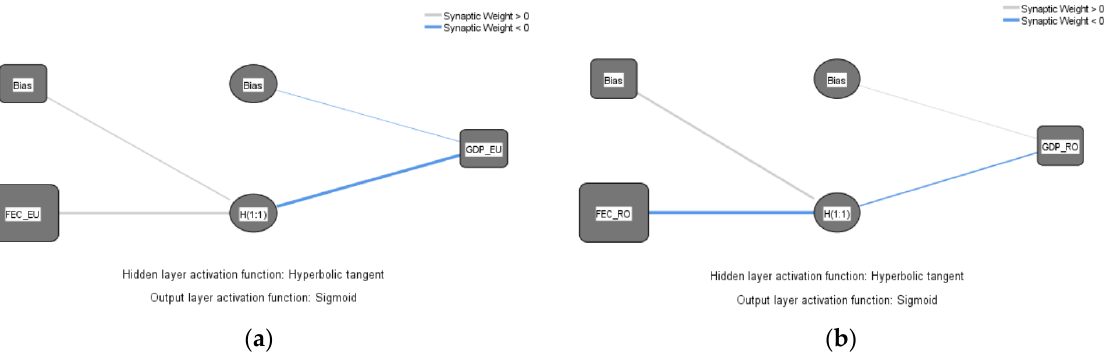
Figure 8. MLP network for identifying the influences of FEC on GDP at the EU and RO levels for 2009–2020: ( a ) EU; ( b ) RO. 2009–2020: ( a ) EU; ( b )